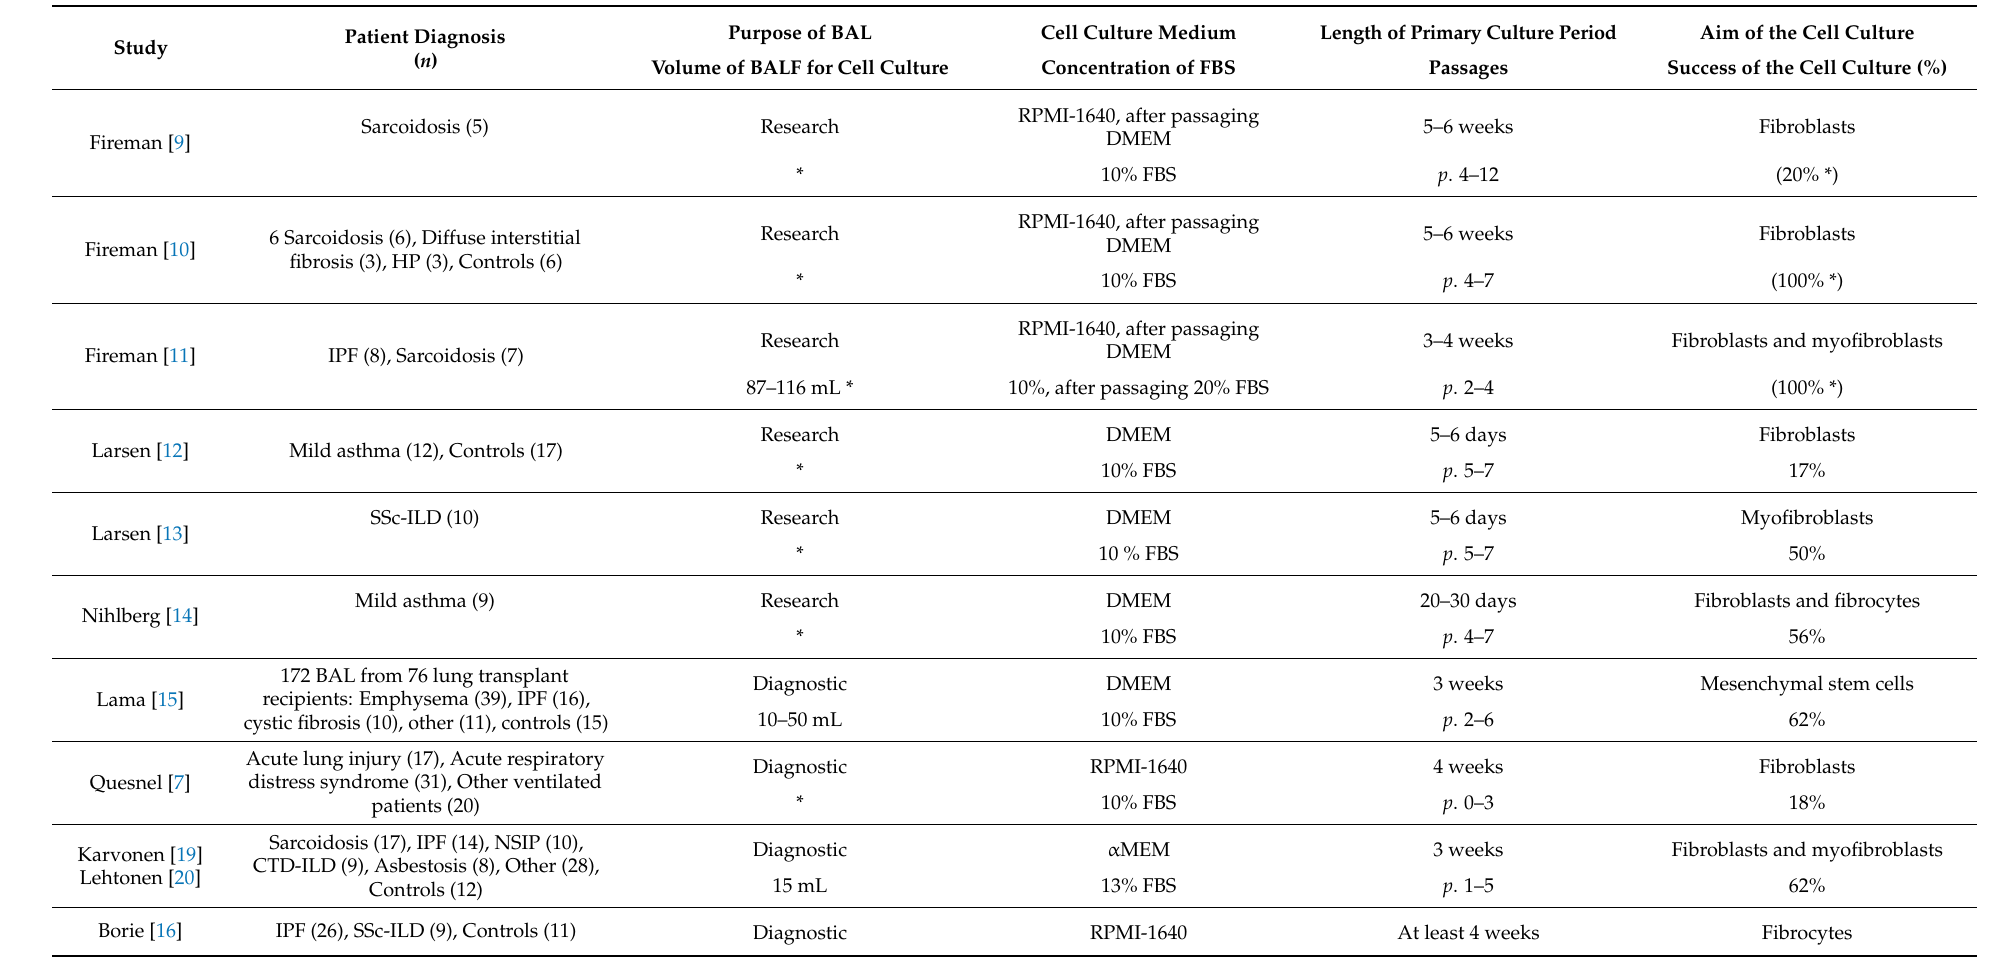
Table 1. Studies with cultured stromal cells derived from